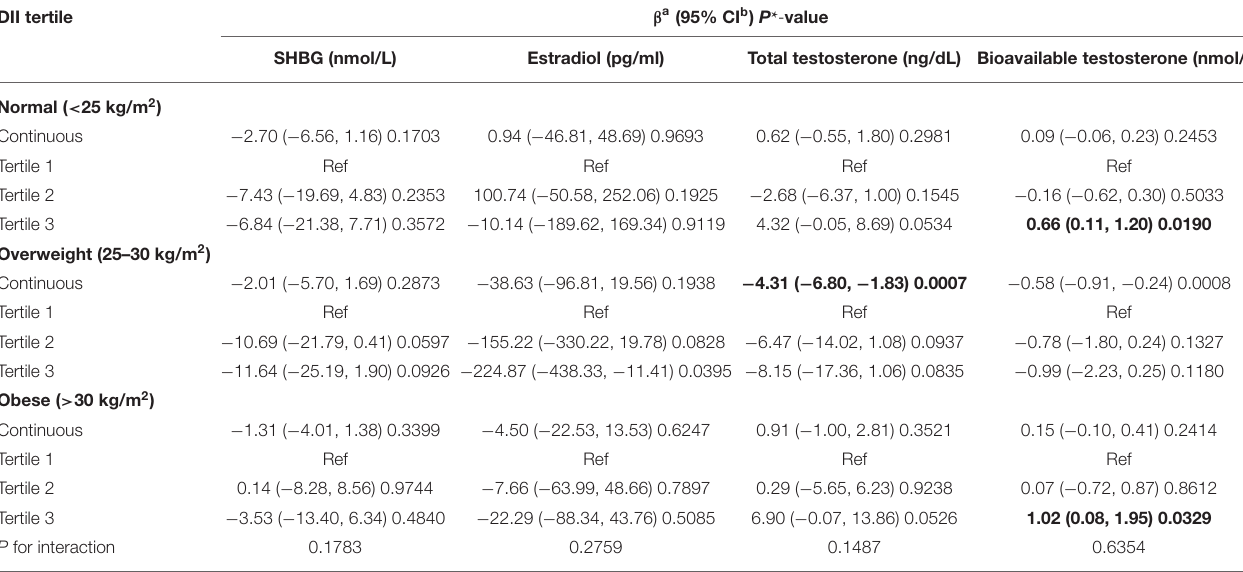
TABLE 3 | BMI-stratified subgroup analysis of association between dietary inflammatory index and sex hormone & sex hormone binding globulin. DII